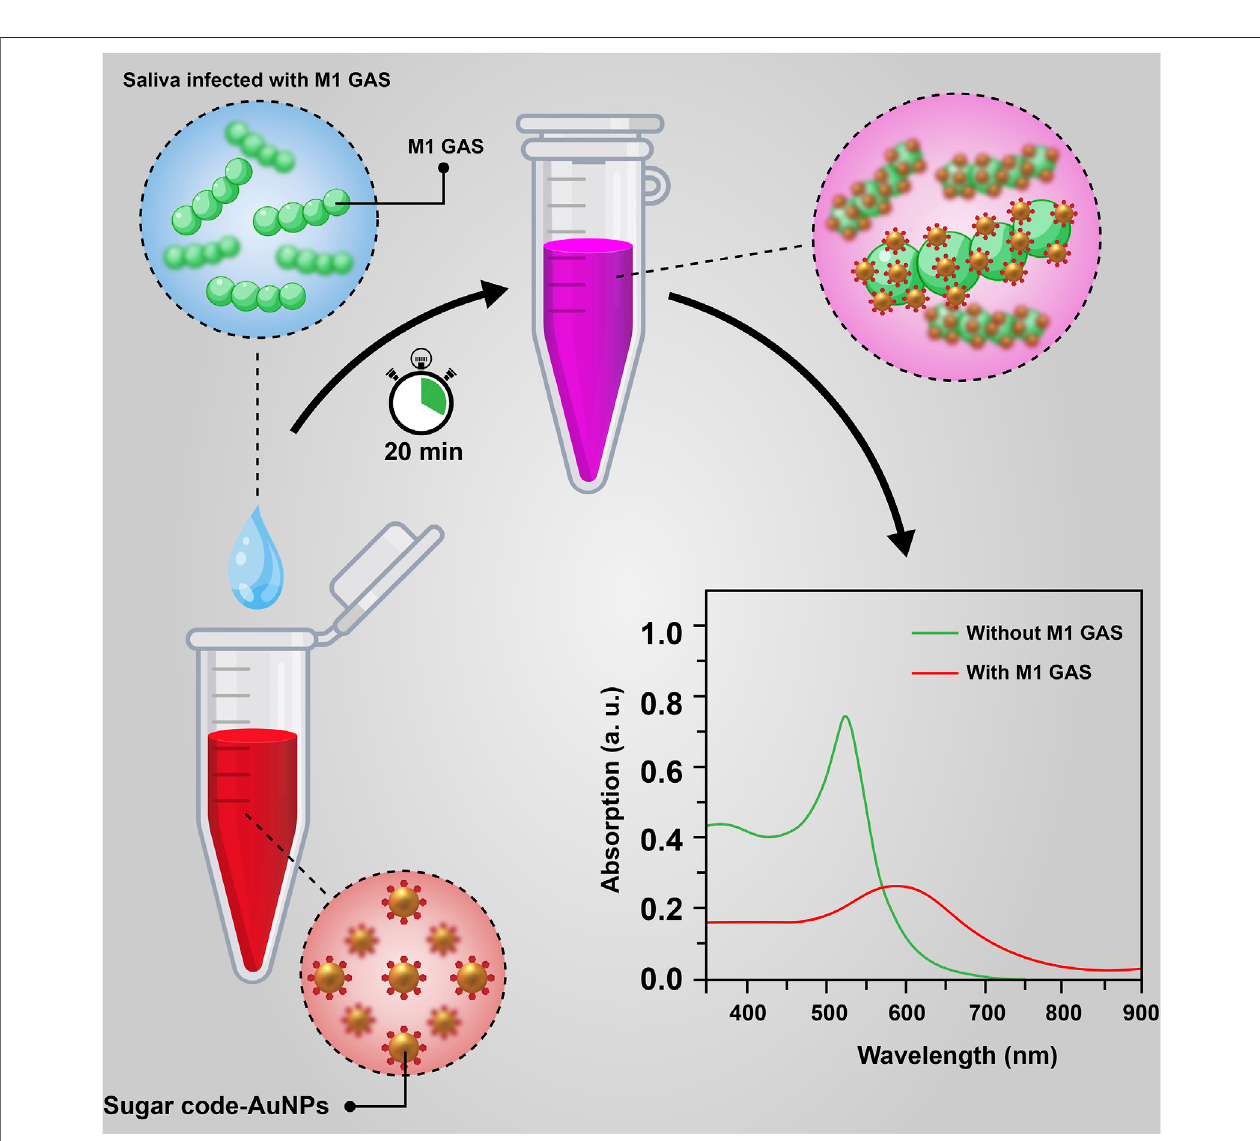
FIGURE 7 | A schematic illustration of nanobiosensor based on the aggregation of sugar code-AuNPs for the rapid detection of M1 GAS.